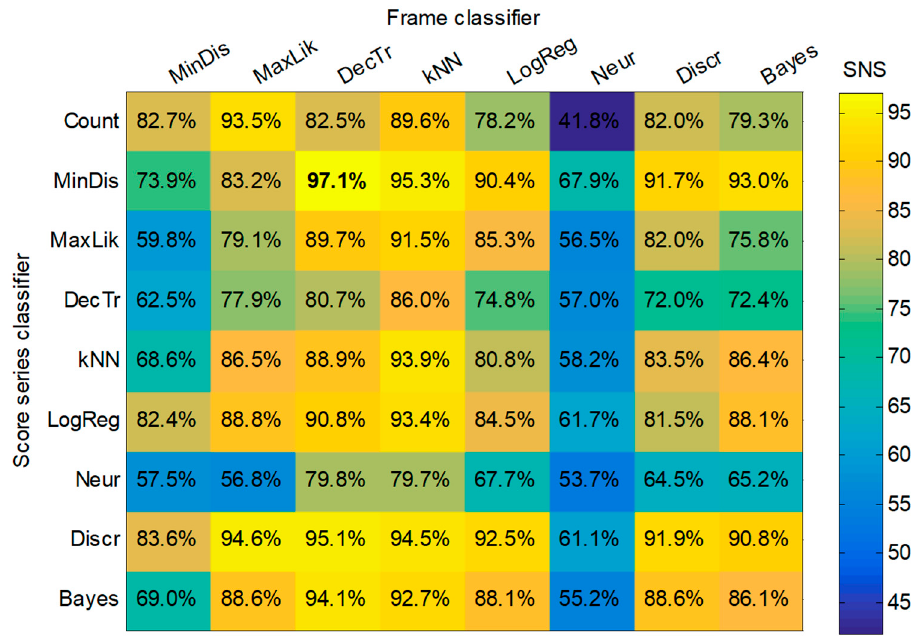
Figure 15. Matrix of SNS values for every pair (score, frame) classifiers.